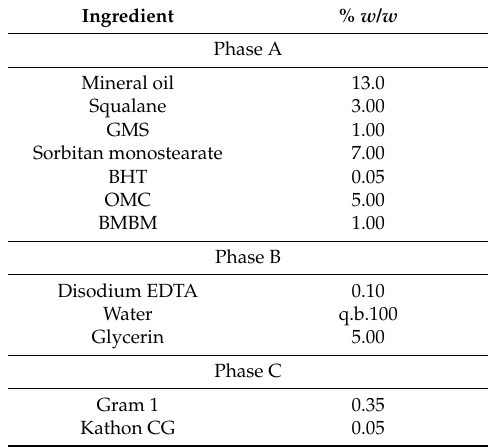
Table 2. Composition (% w / w ) of water in oil (W/O) emulsion 3.